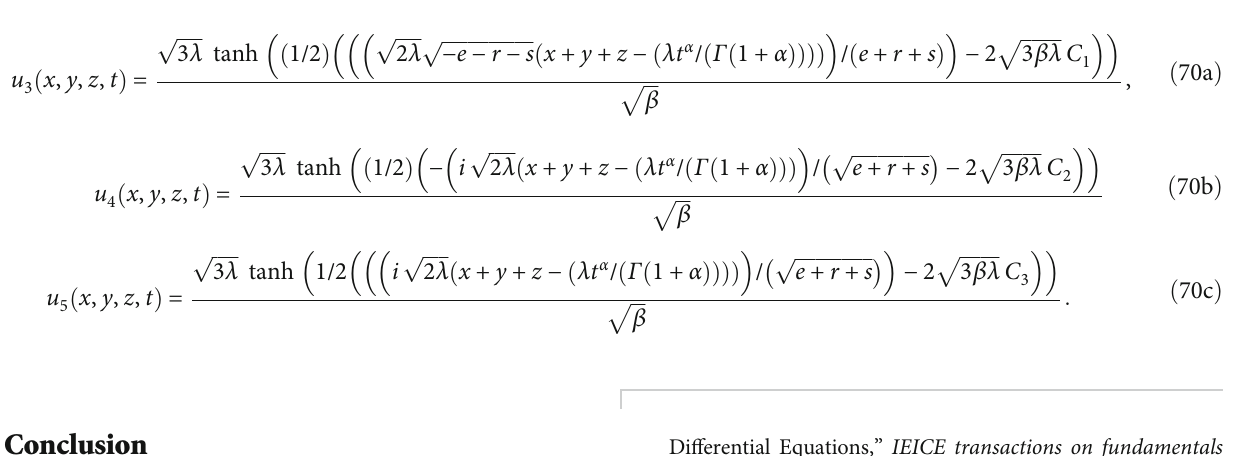
ffiffiffiffiffiffiffiffiffiffiffiffiffiffiffiffiffiffi p − e − r − s